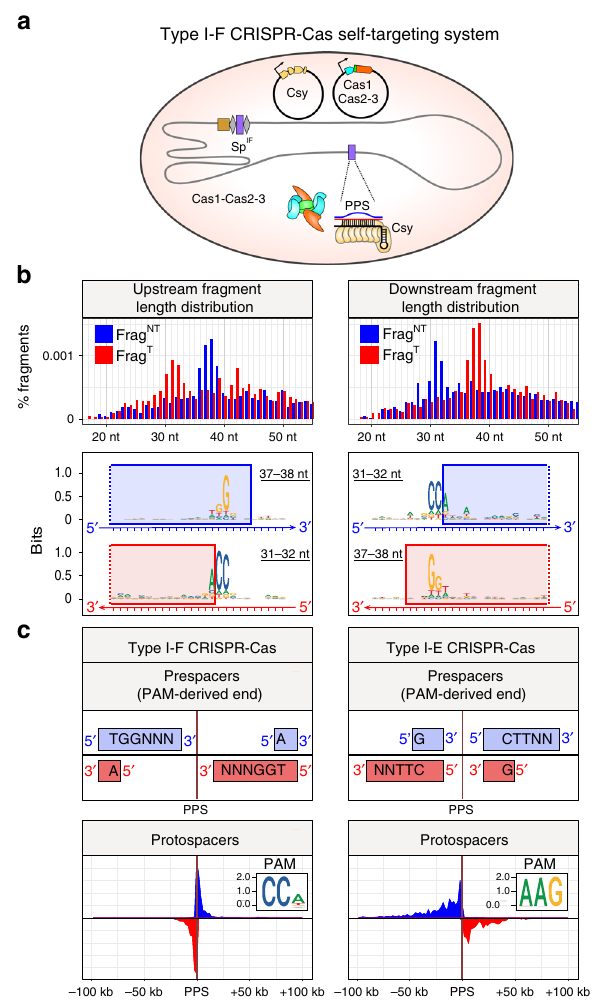
Fig. 4 Identi fi cation of spacer precursors generated in a type I-F self- targeting system by FragSeq. a Components of type I-F CRISPR – Cas self- targeting system. Shaded oval, E. coli cell; gray line, chromosomal DNA; black line, plasmid DNA; orange, tan, blue, and green pentagons, cas and csy genes; brown rectangle, array leader sequence; gray diamonds, array repeat sequences; purple rectangles, spacer and chromosomal PPS targeted by spacer-derived crRNA; Csy, type I-F effector complex; Cas1 – Cas2-3, complex of Cas1 and Cas2-3 proteins. b FragSeq results: length distributions of fragments (top) and sequence features of PPS-region sequences from which fragments are derived (bottom). Logos for 31 – 32-nt fragments were generated by aligning sequences 10-nt upstream to 15-nt downstream of the fragment 5 ′ end. Logos for 37 – 38-nt fragments were generated by aligning sequences 20-nt upstream to 5-nt downstream of the fragment 3 ′ end. Blue rectangles, sequences present in Frag NT ; red rectangles, sequences present in Frag T . c Comparison of PPS-region- derived fragments and PPS-region protospacers in type I-F and type I-E self- targeting systems. Inset, logo derived from alignment of PPS-region